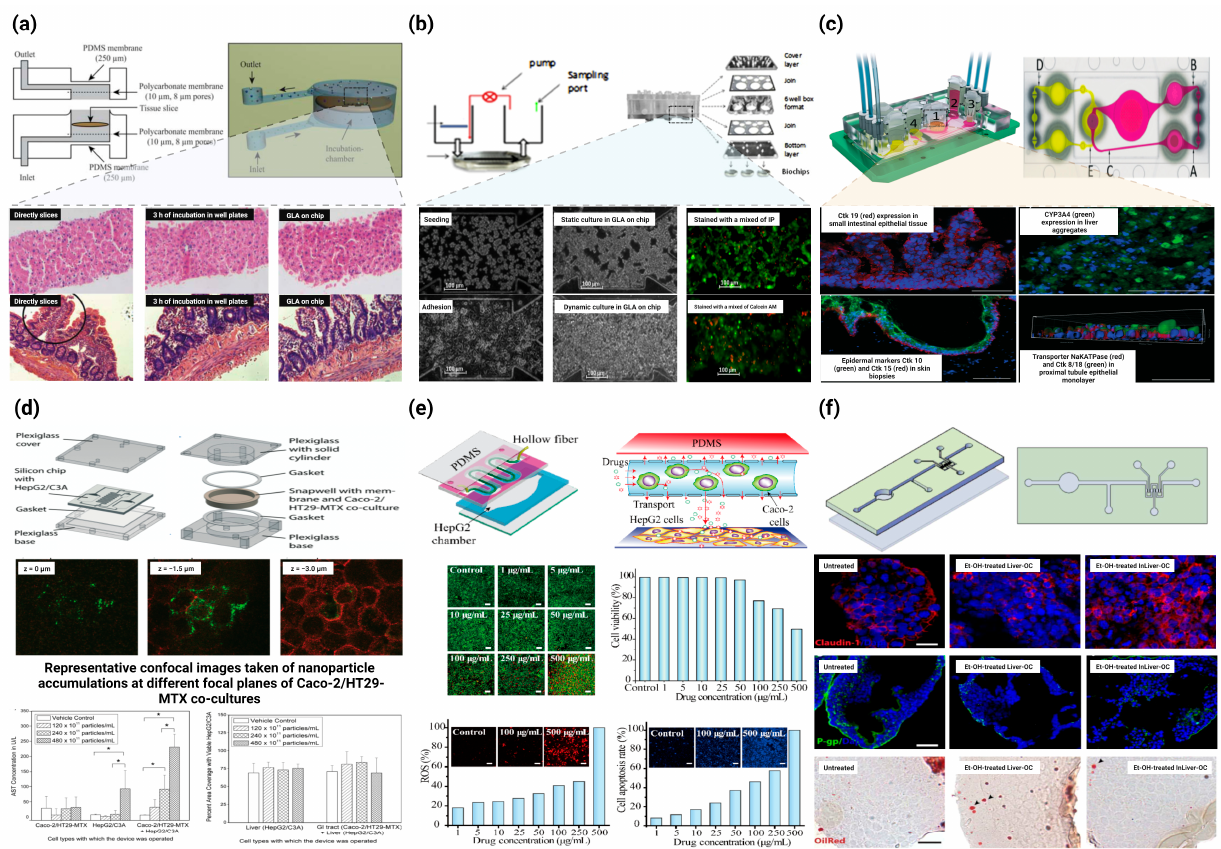
Figure 8. Application of GLA-on-chip in drug experiments and disease models. ( a ) A microfluidic approach for in vitro assessment of inter-organ interactions in drug metabolism using GLA-on-chip. Top: Schematic illustration and photograph of the PDMS biochip. Bottom: Morphological evaluation of liver and intestinal slices directly after slicing, after 3 h of incubation in well plates, and in the biochip. (Magnification: 100×) [88] ©Copyright 2010, Royal Soc Chemistry. ( b ) Development of a new microfluidic platform integrating co-cultures of intestinal and liver cell lines. Top: Principle, design of GLA-on-chip. Bottom: Microscopic analysis of HepG2 C3A integrity in the microchips [89] ©Copyright 2014, Elsevier. ( c ) A four-organ-chip for interconnected long-term co-culture of human intestine, liver, skin, and kidney equivalents. Top: The microfluidic four-organ-chip device at a glance. Bottom: Performance of human tissues in the 4 °C after 28 days of co-culture [58] ©Copyright 2015, Royal Soc Chemistry. ( d ) Body-on-a-chip simulation with gastrointestinal (GI) tract and liver tissues suggests that ingested nanoparticles have the potential to cause liver injury. Top: Schematic of the silicon chip and GI tract module of the body-on-a-chip system. Middle: Representative confocal images taken of nanoparticle accumulations at different focal planes of Caco-2/HT29-MTX co-cultures. Bottom: Mean concentrations of aspartate aminotransferase (AST) and the percent area of on-chip liver chambers that was covered with viable HepG2/C3A cells after 24 h of exposure to 50 nm carboxylate polystyrene nanoparticles at varying concentrations [97] ©Copyright 2014, Royal Soc Chemistry. ( e ) GLA-on-chip for multiple drugs absorption and metabolism behavior simulations. Top: Schematic illustration of the double-layer microchip. Bottom: Influence of genistein and dacarbazine combination influence on HepG2 cell viability and apoptosis in the intestine–liver model [94] ©Copyright 2018, Science Press. ( f ) GLA-on-chip reveals the intestinal protective role on hepatic damage by emulating ethanol first-pass metabolism. Top: Schematic representation of the InLiver-OC and CFD study. Bottom: Protective role of 3D-HIM on Et-OH-induced